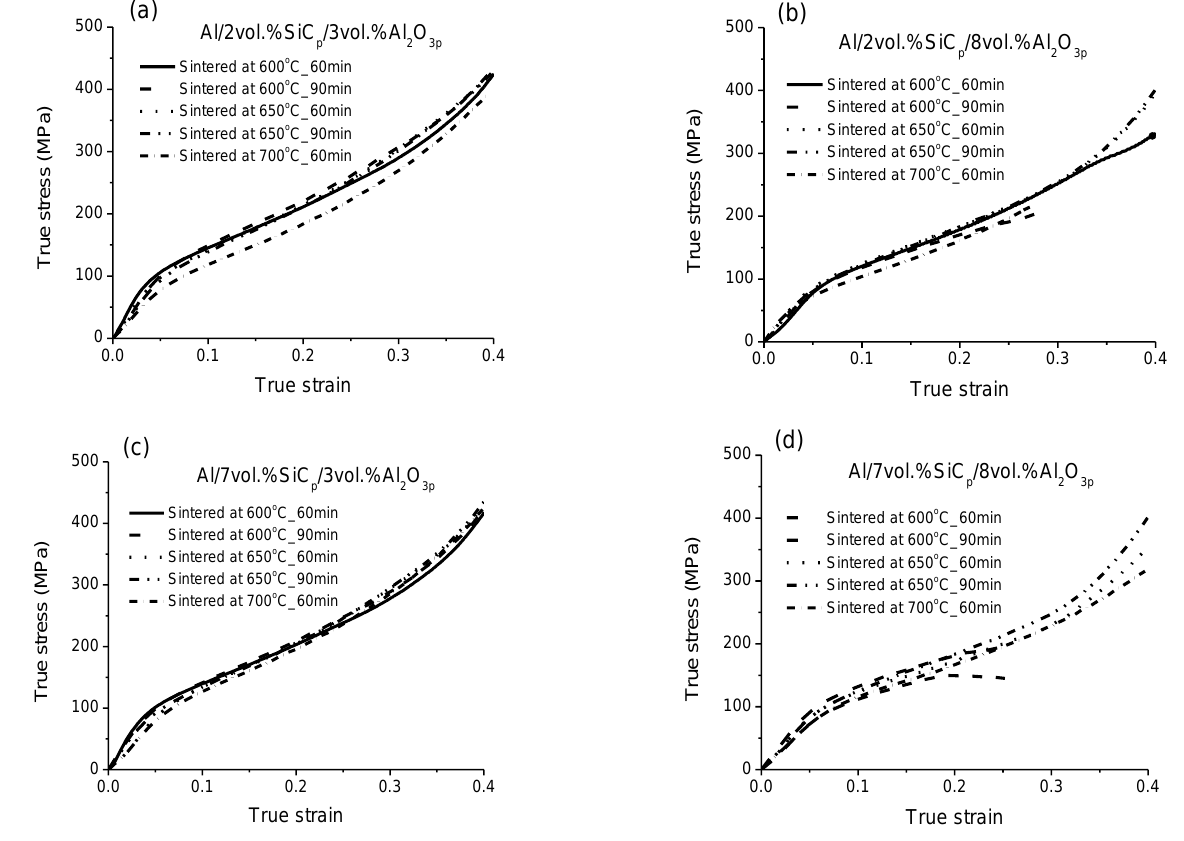
Figure 8. True stress versus true strain curves for the Al/SiC p /Al 2 O 3p composite for the different sintering conditions.